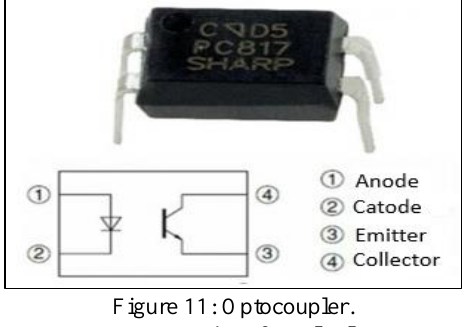
Figure 11: Optocoupler.